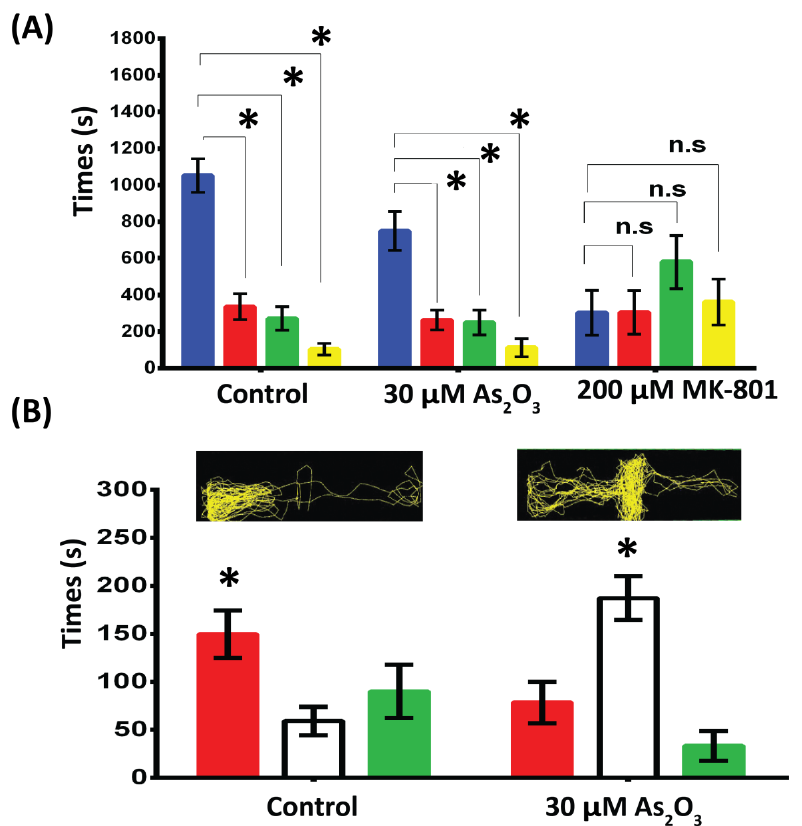
Figure 4. Effects of embryonic As 2 O 3 exposure on the color preference of larval (11 dpf, A ) and adult zebrafish ( B ). ( A ) In the 11 dpf larval test, a cross maze with four different-colored cambers was used. Reduction in color preference for blue in As 2 O 3 -exposed larvae compared to the control group. No significant differences were observed in color preference for red and green in control or As 2 O 3 -exposed larvae. However, MK-801-exposed larvae showed no clear color preference ( B ) Five-minute video tracking of color preference in adult fish after associative learning. Adult fish were acclimated to the three-chamber maze for 6 days with red food association before the test on the 7th day. As 2 O 3 -exposed zebrafish showed no significant preference for either green or red color Data are presented as mean ± SEM, ( ∗ p ≤ 0.005). n = 30 larvae per group, n = 22 adults per group. ∗ Significance at p ≤ 0.05 between left/center/right and between two color arms for each test, n.s: not significant